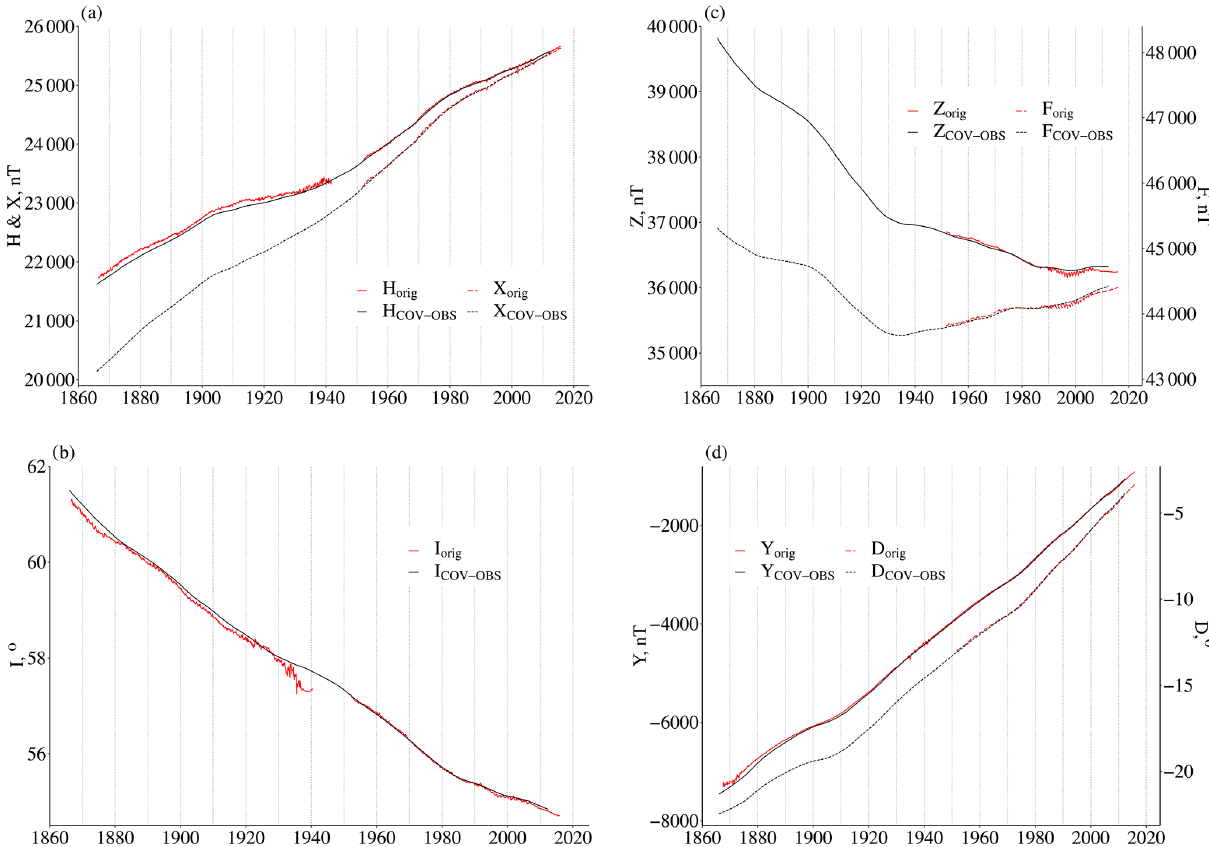
Figure 1. For the 1866–2015 time period, measured series (red; orig) of the COI geomagnetic field elements and COV-OBS model predic- tions (black) of (a) H and X , (b) I , (c) F and Z , and (d) D and Y .